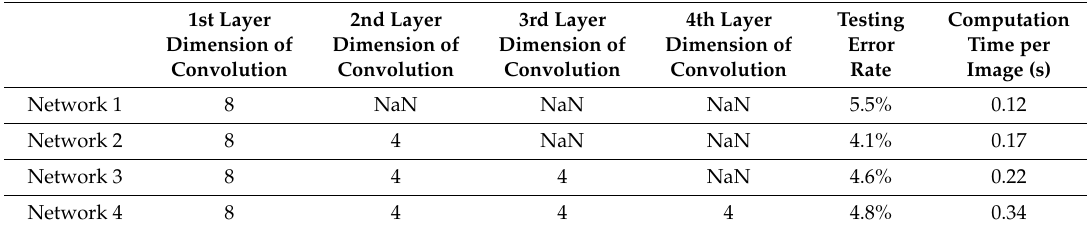
Table 3. Performance evaluation of di ff erent convolution layers.